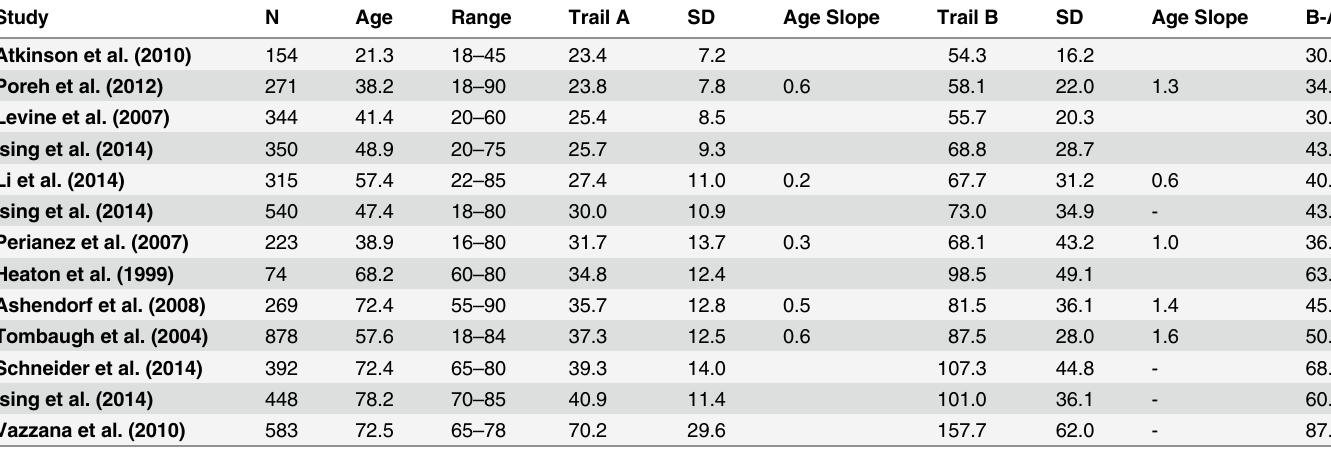
Table 1. Recent large scale studies of normative Trails A and B performance.